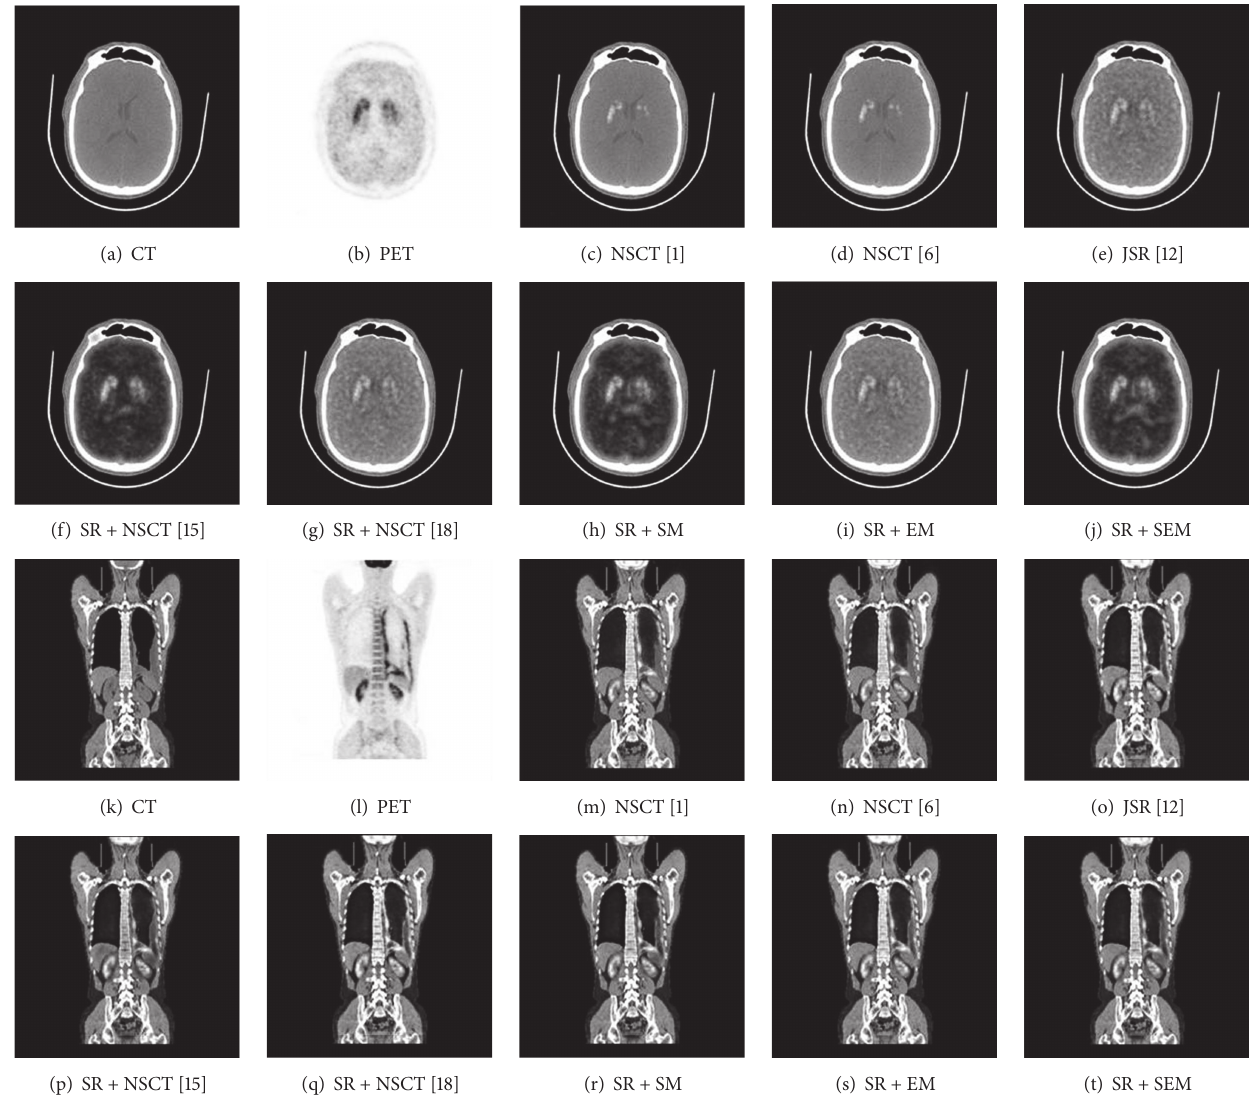
Figure 7: The CT and PET image fused results of different fusion methods.